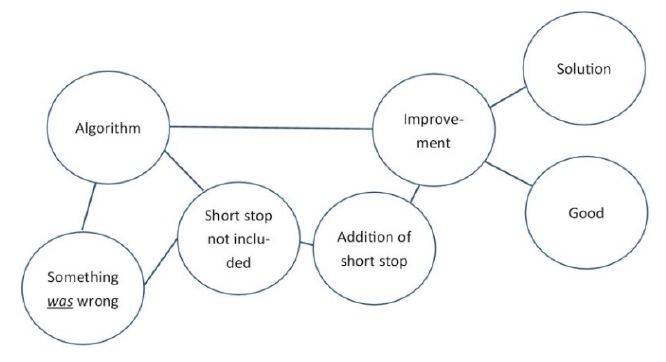
Figure 5. Associations after bug fix.